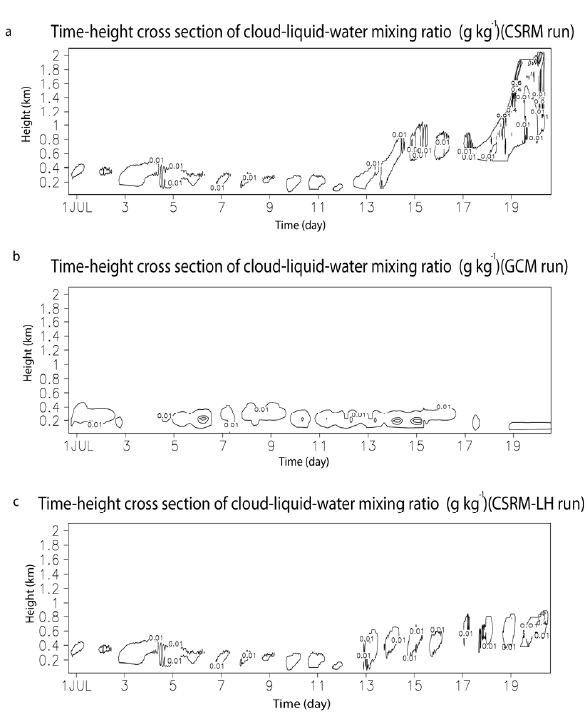
Table 2. For each combination, a simulation is carried